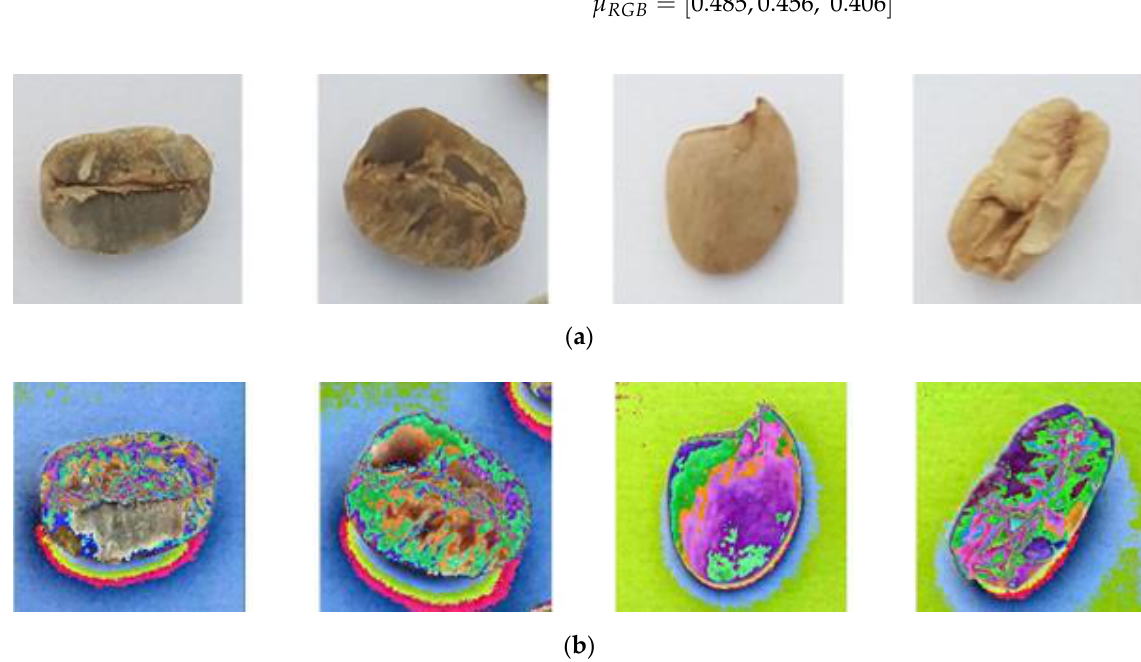
Figure 10. Images of green coffee beans: ( a ) before normalization, ( b ) after normalization.